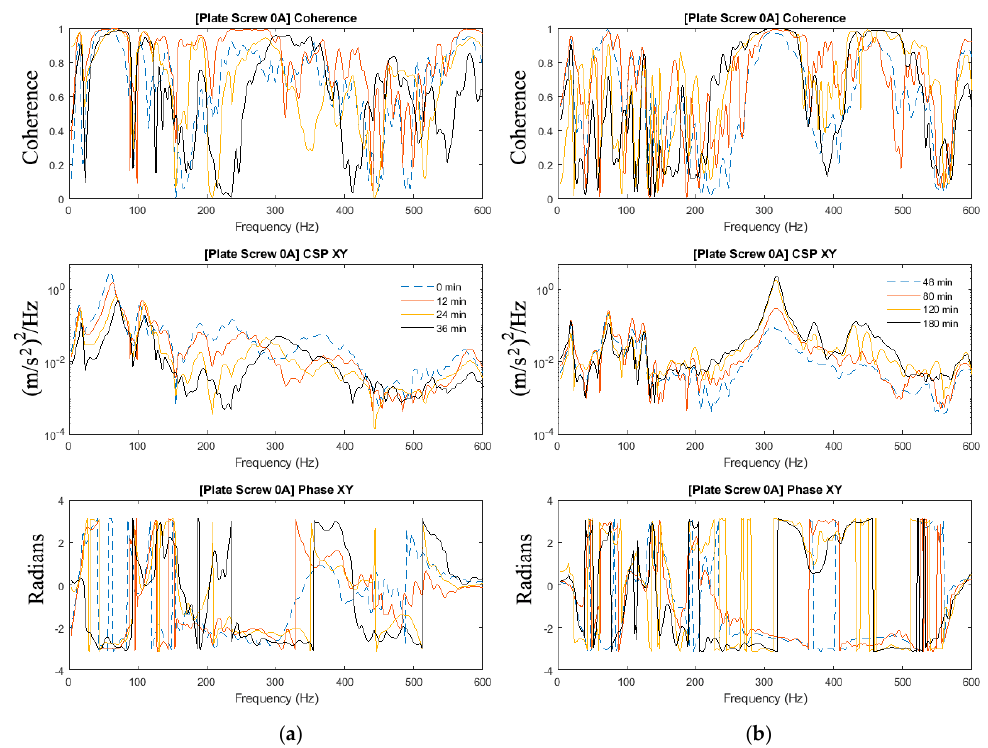
Figure 4. Coherence, cross-spectra and phase functions of Test #0A experimental investigations; (a) from 0 to 36 minutes and (b) from 48 to 180 minutes.